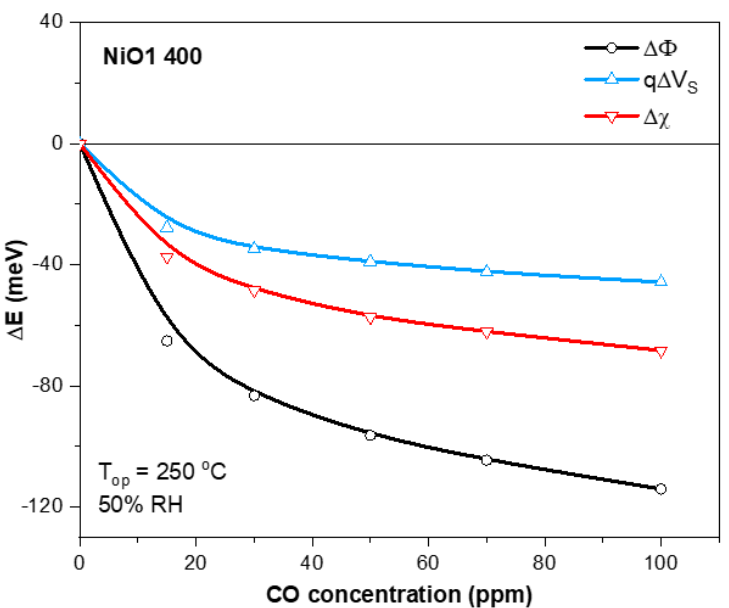
Figure 7. The decoupled energetic contributions with respect to CO concentration for NiO1 400 when operated at 250 °C under 50% RH background atmosphere.